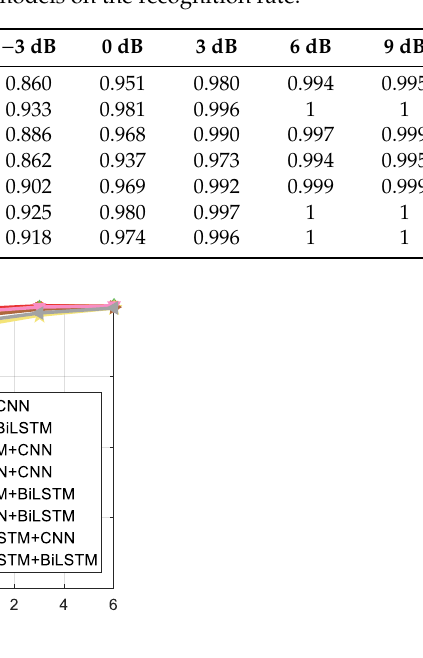
Figure 22. The effect of different feature extraction models on the recognition rate. Figure 22. The e ff ect of di ff erent feature extraction models on the recognition